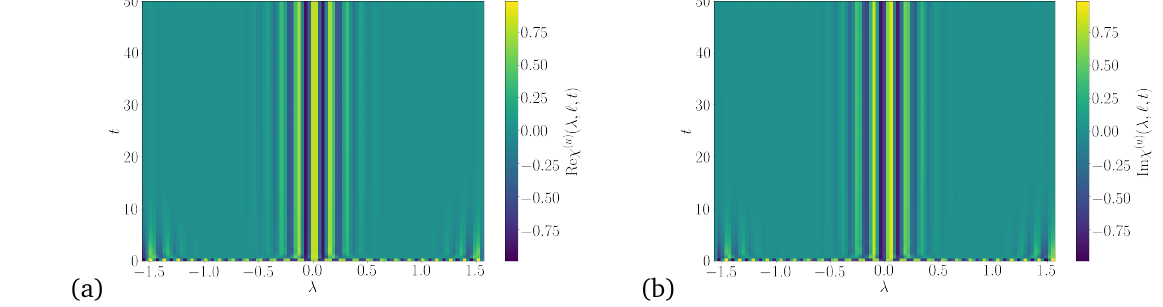
Figure 20: (a) Real and (b) imaginary parts of χ ( u ) ( λ , (cid:96) = 50, t ) as functions of λ and t for a transverse field quench from h = 5 to h = 1.5. We observe that the characteristic function is small unless λ is small. The behaviour for quenches within the ferromagnetic phase and quenches between the phases is